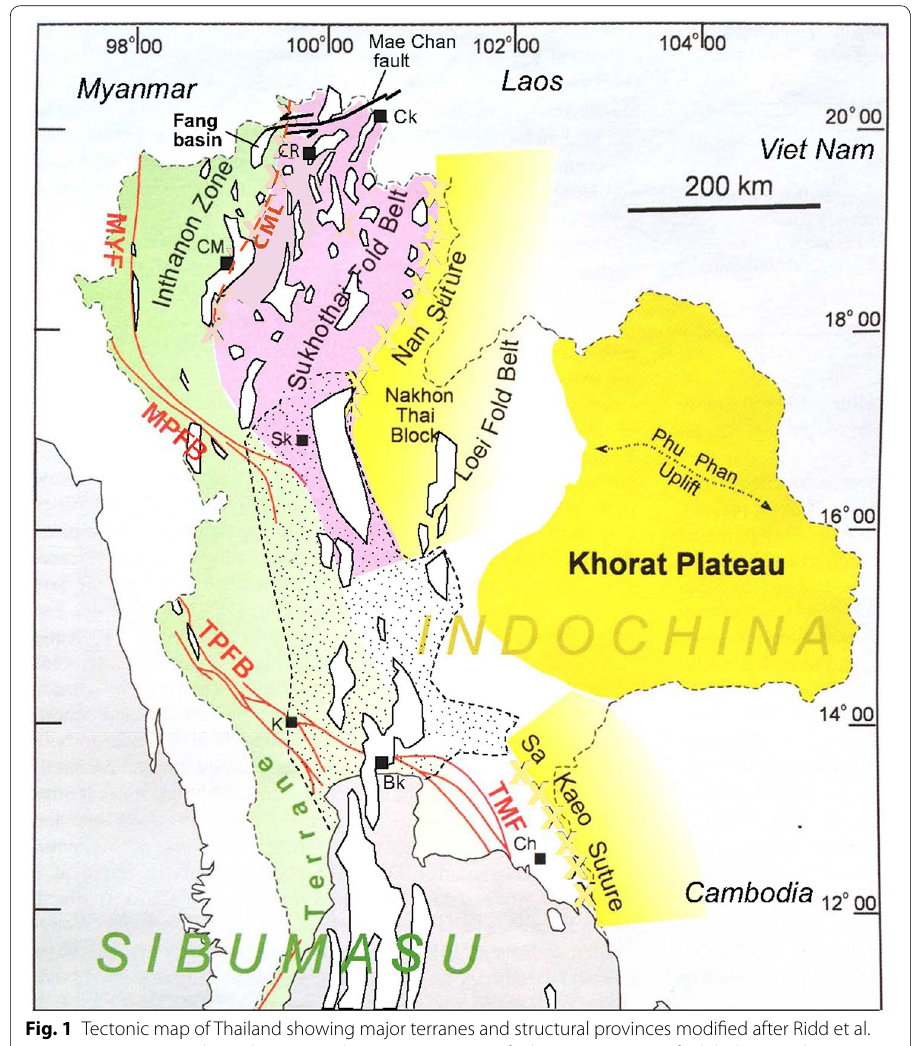
Fig. 1 Tectonic map of Thailand showing major terranes and structural provinces modified after Ridd et al. (2011). Major tectonic lines shown in red are MYF Mae Yuam fault; MPFB Mae Ping fault belt; TPFB Three Pagodas fault belt; TMF Tha Mai fault; CML Chiang Mai line. Cenozoic rift basins shown in outlined white color after Uttamo et al. (2003). Bk Bangkok; Ch Chanthaburi; CK Chiang Khong; CM Chiang Mai; CR Chiang Rai; K Kanchanaburi; Sk